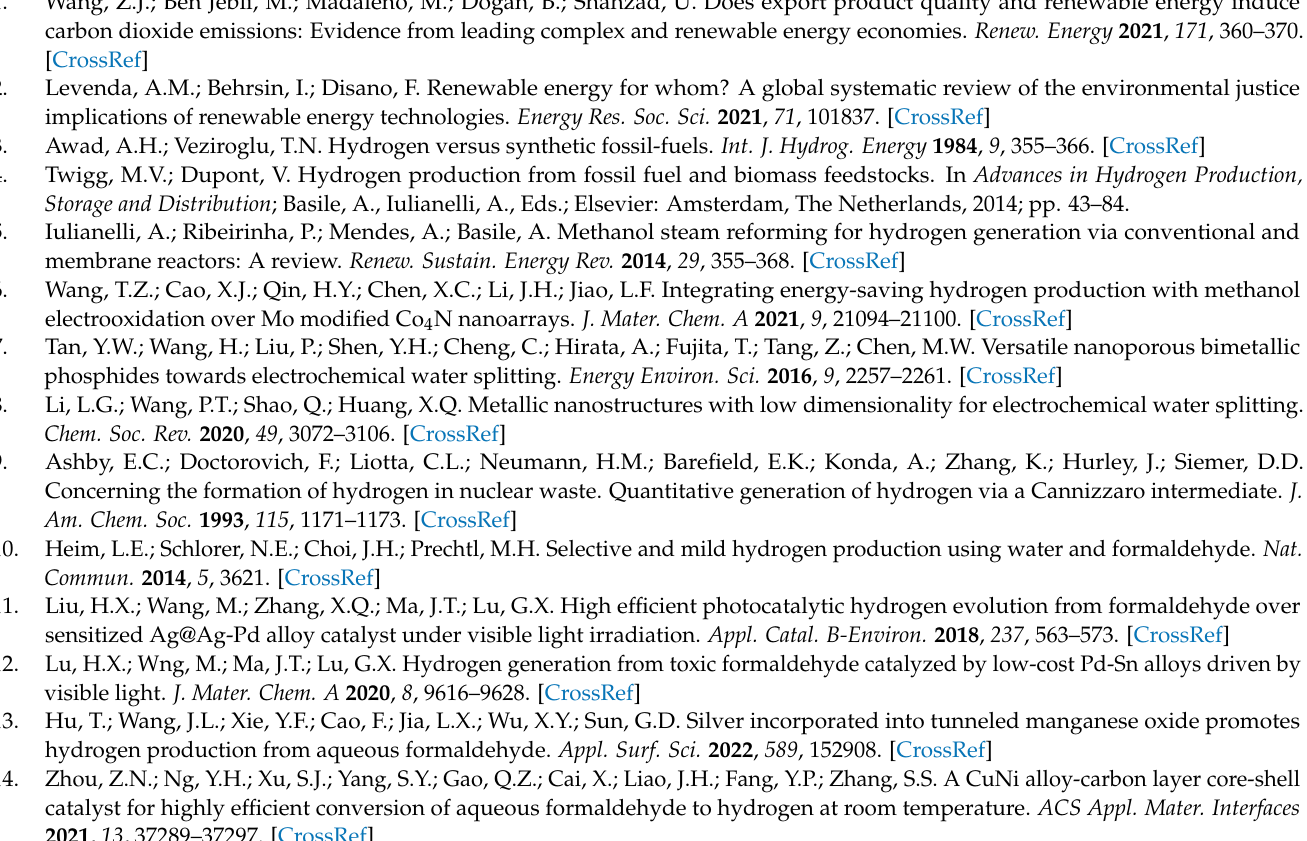
and pore size distribution; Table S1: Specific surface area, pore volume and average pore diameter results; Figure S2: TEM images; Figures S3–S5: SEM images; and Figures S6–S9: TEM images. Figure S10: Hydrogen production and electrochemical FA detection